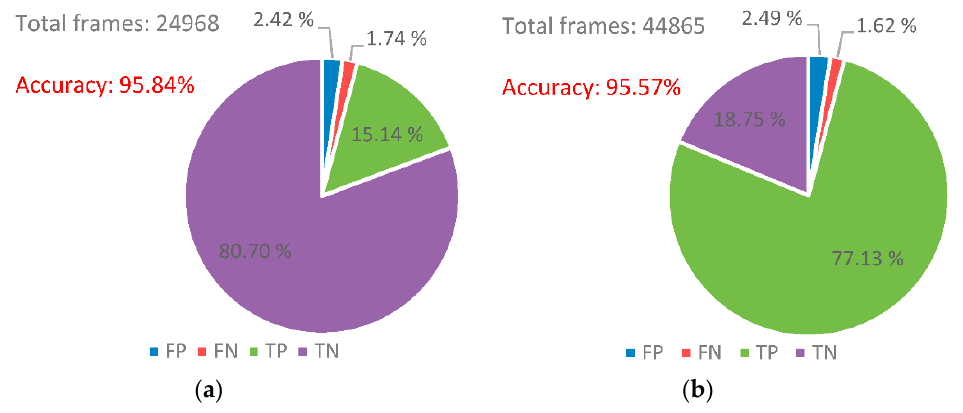
Figure 16. Results on benchmark 2 over: ( a ) day, ( b ) night.